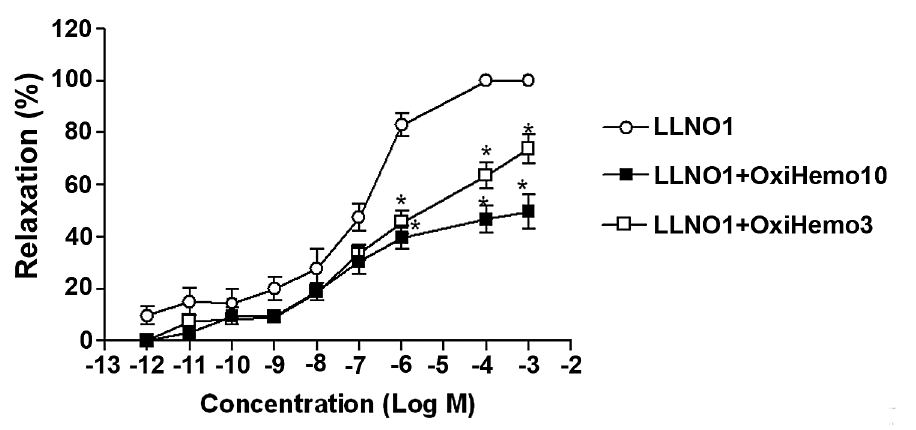
Figure 4 – Effect of LLNO1 alone and in combination with oxyhemoglobin upon rabbit corpus cavernosum strips. The RbCC strips were precontracted with 1 µ M phenylephrine and relaxation concentration/response curves (concentrations graded from 10 -12 to 10 -3 M) were plotted for LLNO1 alone and in combination with 3 µ M or 10 µ M oxyhemoglobin. Findings are expressed as average ± standard error, based on six experiments. * p < 0.05 vs. LLNO1 + oxyhemoglobin (ANOVA followed by the Tukey-Kramer